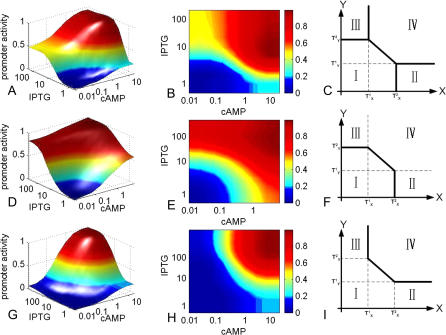
Input Function of the Wild-Type
lac Promoter Region and Two Variant CRRs
The input functions describe the promoter activity as a function of the concentrations of the two inducers IPTG (in μM) and cAMP (in mM), measured in midexponential growth in an automated fluorimeter by means of a GFP-promoter fusion on a low-copy plasmid. (A) Surface plot of log wild-type input function. (B) Contour plot of wild-type input function. (C) Schematic drawing showing the activation thresholds and the four plateaus of the input function. (D–F) Same for strain U340, with an OR-like input function. (G–I) Same for strain U339 with an AND-like input function. The plateaus of the input functions are marked by roman numerals in (C, F, and I). Plateau I occurs at zero concentration of inducers, plateau II at saturating cAMP and zero IPTG, plateau III at saturating IPTG and zero cAMP, and plateau IV occurs when both inducers are saturating.